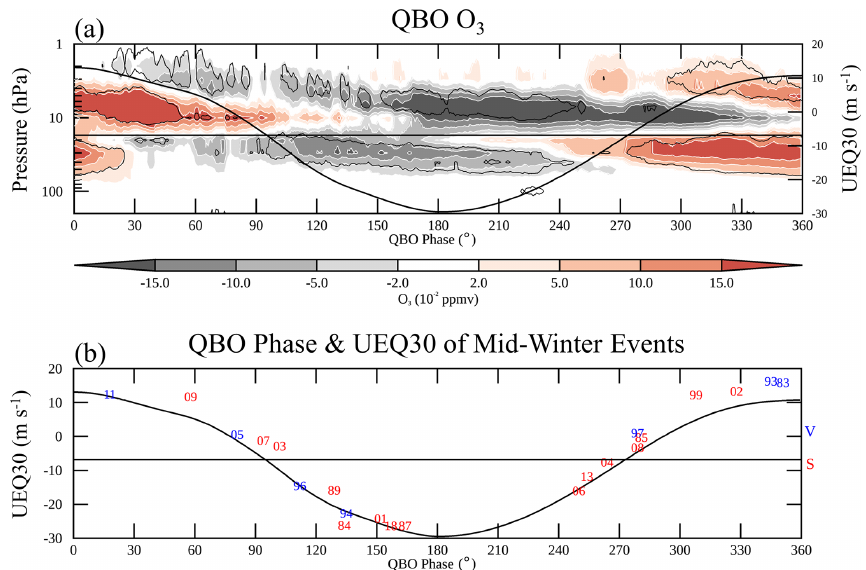
Figure 4. Composites for QBO events. (a) QBO influences on tropical ozone – shading shows composite tropical ozone anomalies ( ± 15 ◦ ) from 16 QBO cycles (1980–2018), and black contours represent statistical significance at the 95% level. A QBO cycle is defined by two consecutive positive UEQ30 maxima. (b) Central date timing of selected midwinter stratospheric circulation events relative to the QBO phase. Red (blue) numbers indicate years and QBO phase of SSWs (VIs); S and V on the y axis are the mean UEQ30 of all SSWs and all VIs (except 2016), respectively. The 2015–2016 QBO event has been purposely excluded from this analysis due to the anomalous nature of this event. The horizontal line is the climatological mean